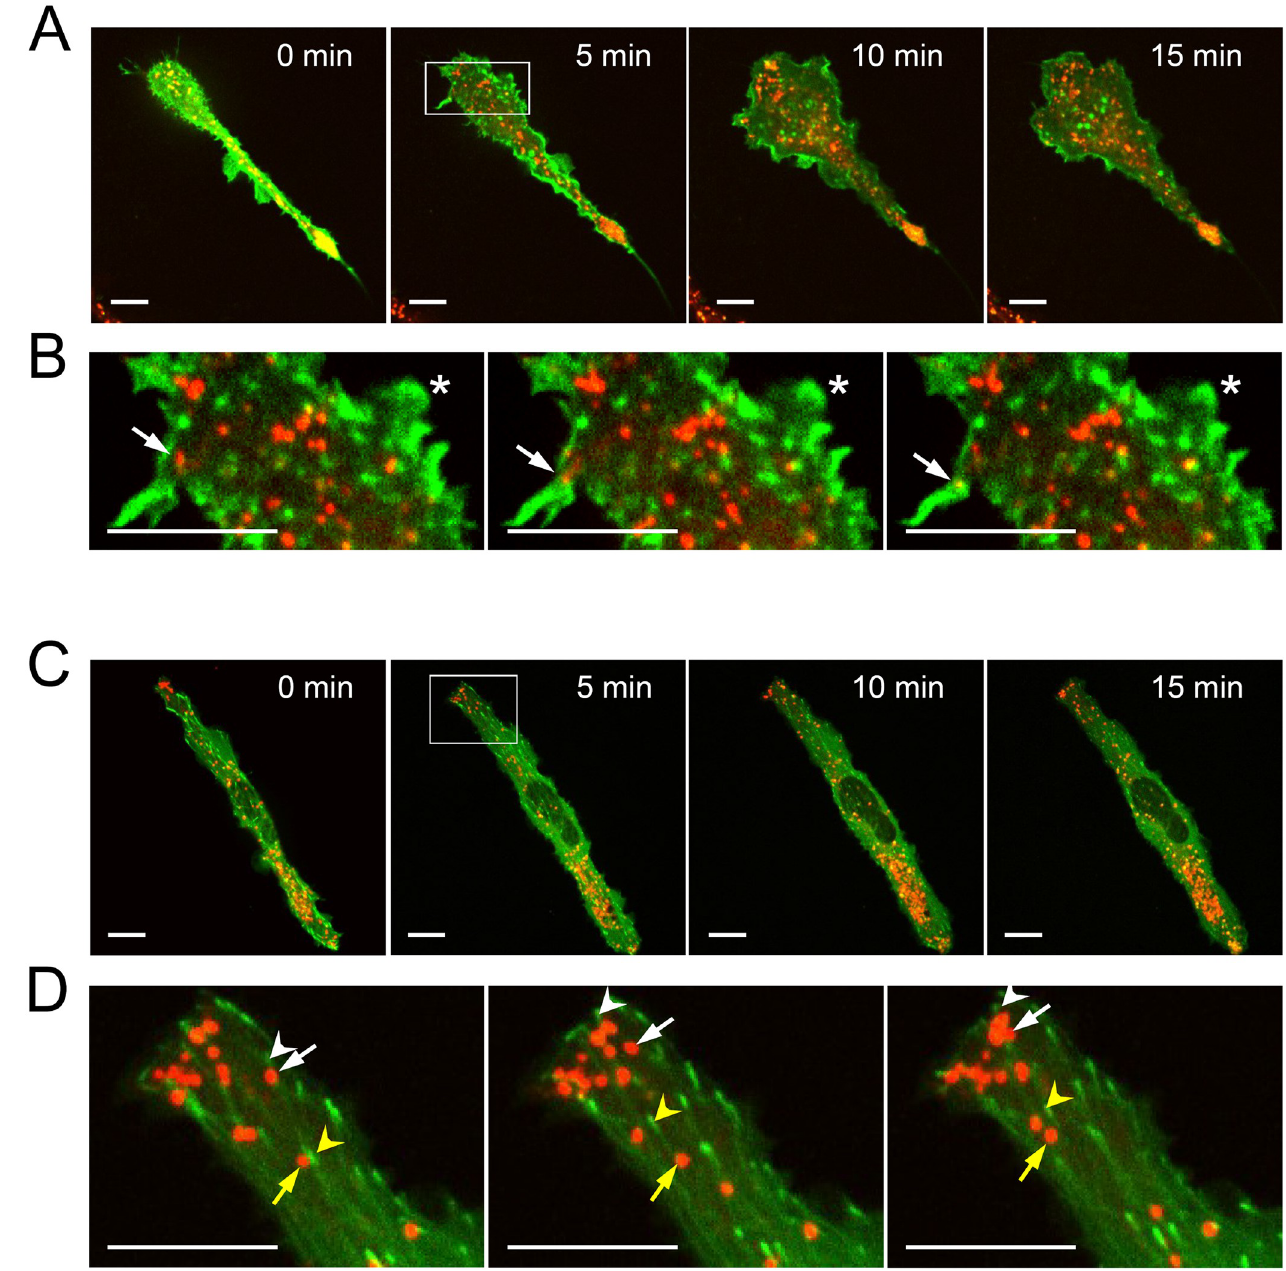
Fig 1. Live-cell imaging of cytoskeletal dynamics and granule movement during stimulation of mast cells. RBL-2H3 cells were transfected with Lifeact-GFP ( A and B ) or EB3-GFP ( C and D ) to label nascent F-actin and microtubules respectively, and granules were stained with LysoTracker Red. A) Representative confocal images from se S1 Video (https://doi.org/10.6084/m9.figshare.19349555.v1) of F-actin remodeling and granule movement during a time course after antigen-stimulation. B) Magnified images from the 5 min time point at 10 s intervals showing the movement of a granule into a pre-existing actin protrusion ( arrow ), and newly forming lamellipodia devoid of granules ( asterisk ). C) Representative confocal images from S2 Video (https://doi.org/10.6084/m9.figshare. 19349552.v1) of nascent microtubule formation and granule movement during a time course after antigen-stimulation. D) Magnified images from the 5 min time point at 10 s intervals showing the movement of granules ( arrows ) is coordinated with the growth of microtubules ( arrowheads ). Scale bar, 10 μ m.